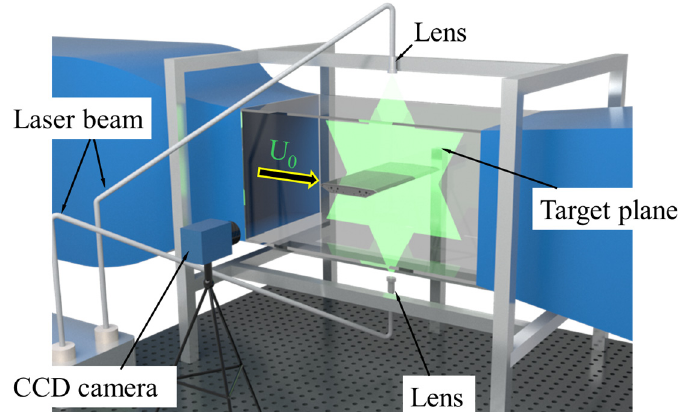
Figure 3. Sketch of the PIV experiment arrangement.